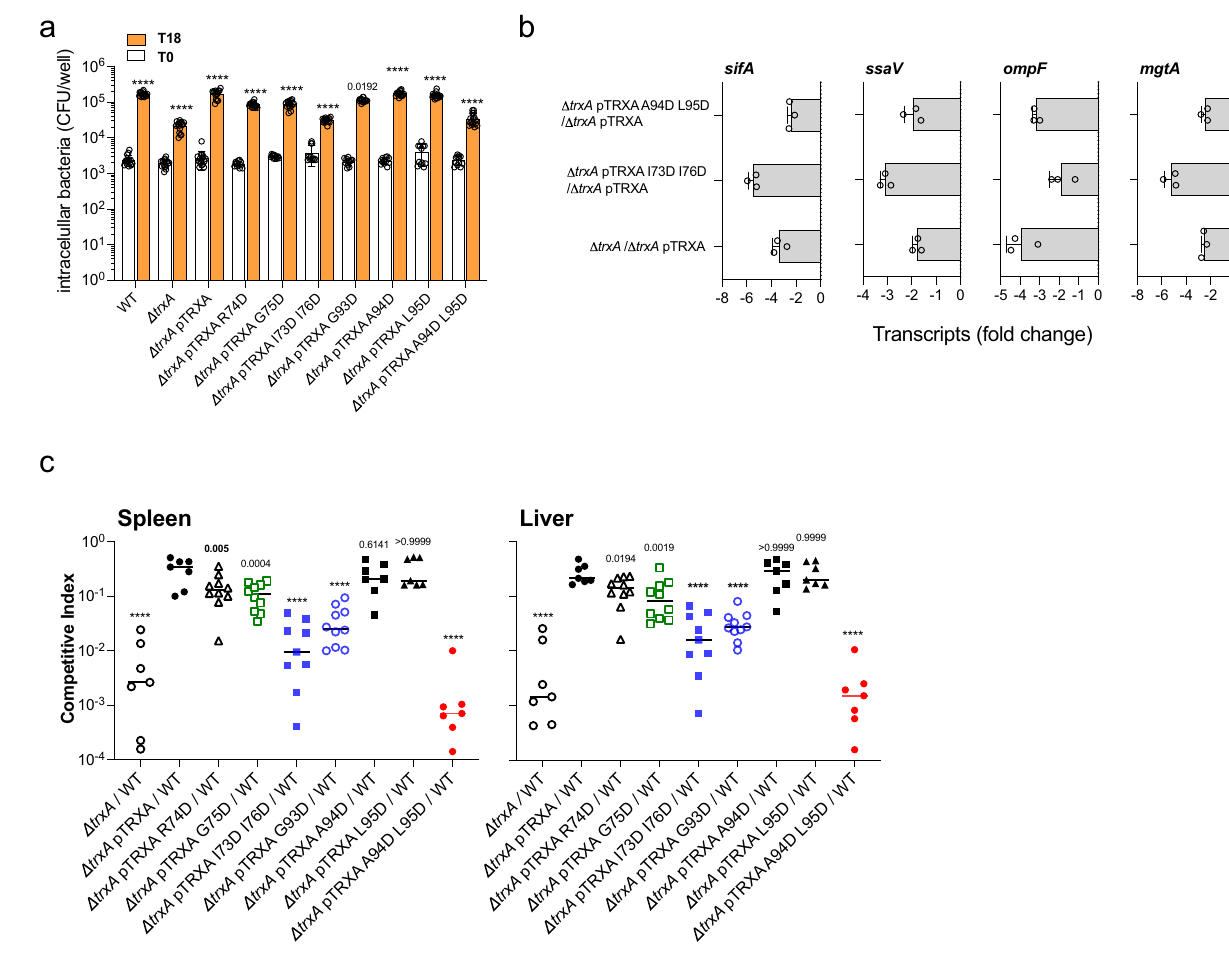
Fig. 4 | Residues in the shared TrxA substrate-binding interface contribute to Salmonella pathogenesis. a Intracellular replication of the indicated Salmonella strainsinJ774cellswasevaluatedbyrecordingCFUattimes0and18hpostinfection. The data are the mean±SD (T0; n =16, 16, 16, 12, 12, 12, 12, 12, 12, 12, T18; n =16 biological replicates). **** p <0.0001, *** p <0.001 as estimated by two-way ANOVA with Dunnet ’ s multiple test correction. b The transcription of SPI-2 ( sifA and ssaV ), ompF , and mgtA genes 8h after infection of J774 cells with the indicated Salmonella strainswasestimatedbyqRT-PCRfollowingthethresholdcycle(2 - ΔΔ CT )method.The data are the mean±SD ( n =3 biological replicates) from three independent (Figs. 6e, S7h), and does not activate ompF in vitro transcription (Figs. 6f, S7h). Aspartic acid substitutions of Ala 136 , Ile 138 or Tyr 230 yield insoluble OmpR proteins in the cytoplasm of Salmonella (Fig. 6g). As described for SsrB 22 , wildtype OmpR segregates in the insoluble fraction in Δ trxA Salmonella (Fig. S7i). In contrast, the OmpR E178K variant, which binds to thioredoxin with seemingly greater af fi nity than wild-type OmpR, partions in the soluble frac- tion (Fig. S7j). Together, our investigations have identi fi ed an extensive region in OmpR, which predominantly encompasses residues in the fl exible linker and C-terminal domain that mediates contact with thioredoxin.